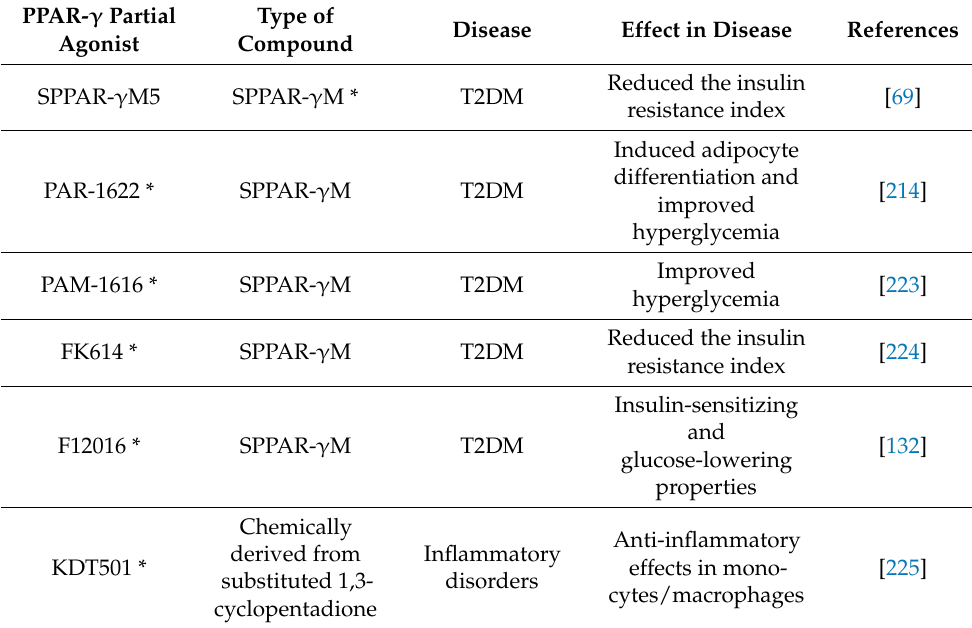
Table 3. Effect of PPAR- γ partial agonists in disease-fate